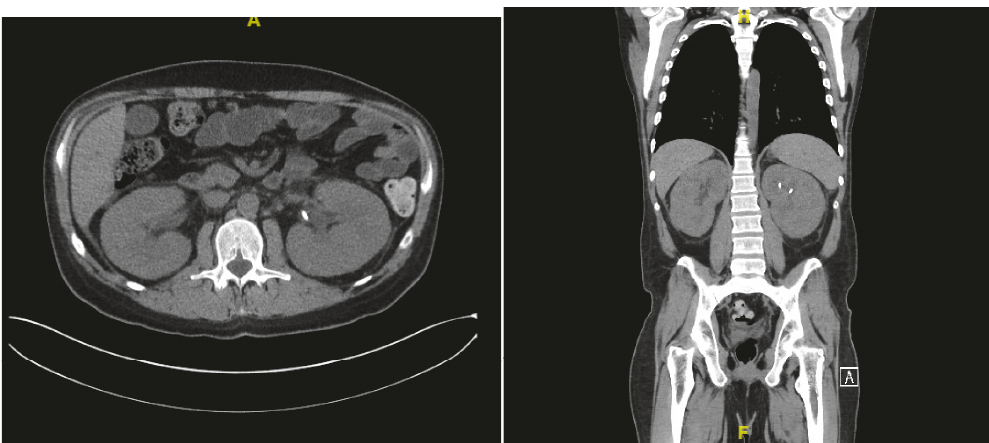
Figure 1: (a), (b) Computed tomography scan showing symmetric enlargement and hypoattenuation of bilateral kidneys with associated fat stranding involving the renal sinuses and perinephric fat. Left sided urinary stent in in place. No hydronephrosis or nephrolithiasis.